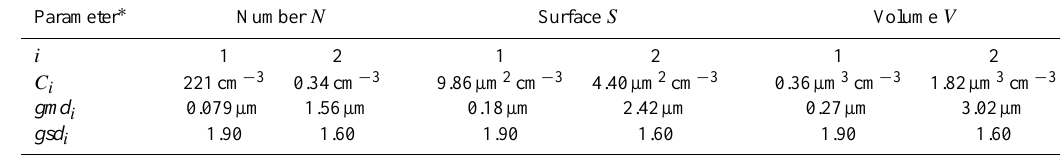
Table 3. Parameters describing two-mode distributions of number, surface, and volume for the plots of Fig. 12. Parameter ∗ Number N Surface S Volume V